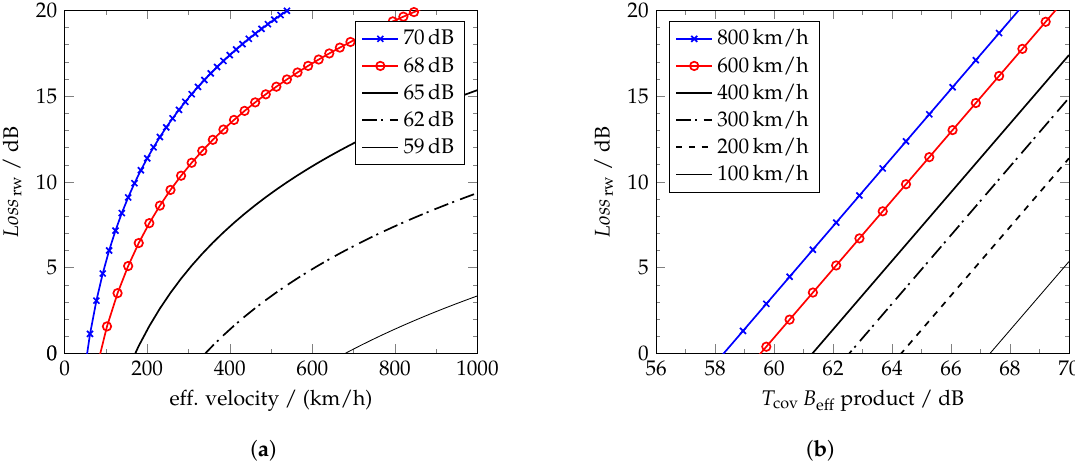
Figure 10. Extension loss in range-Doppler for multiple time-bandwidth products and linear velocities. ( a ) Expressed with f s ≈ B eff for multiple T cov B eff sets. ( b ) Expressed for constant effective velocities.